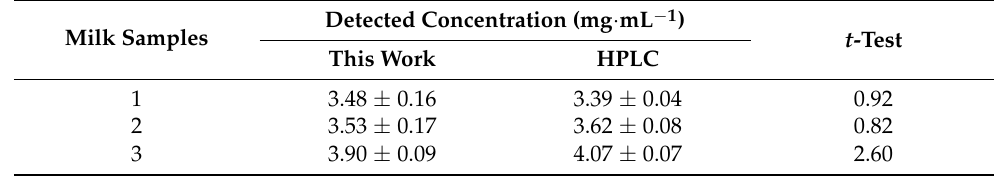
t table = 2.78, p = 0.95, and v =